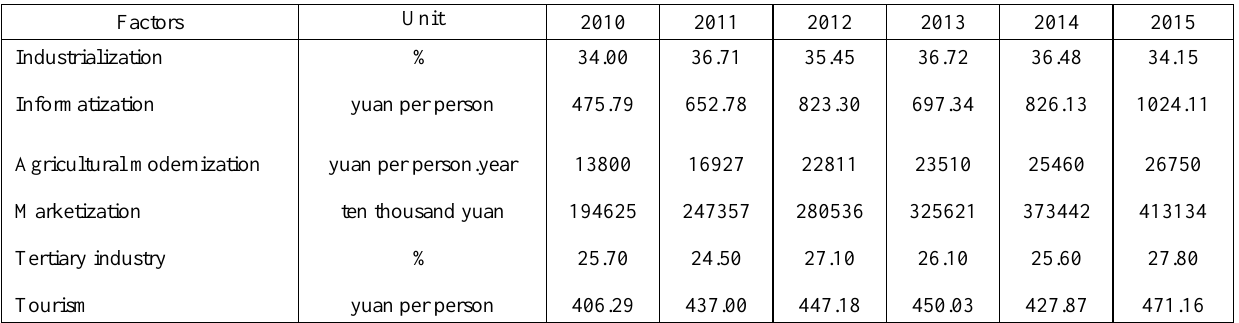
Table 3. Original data of influence